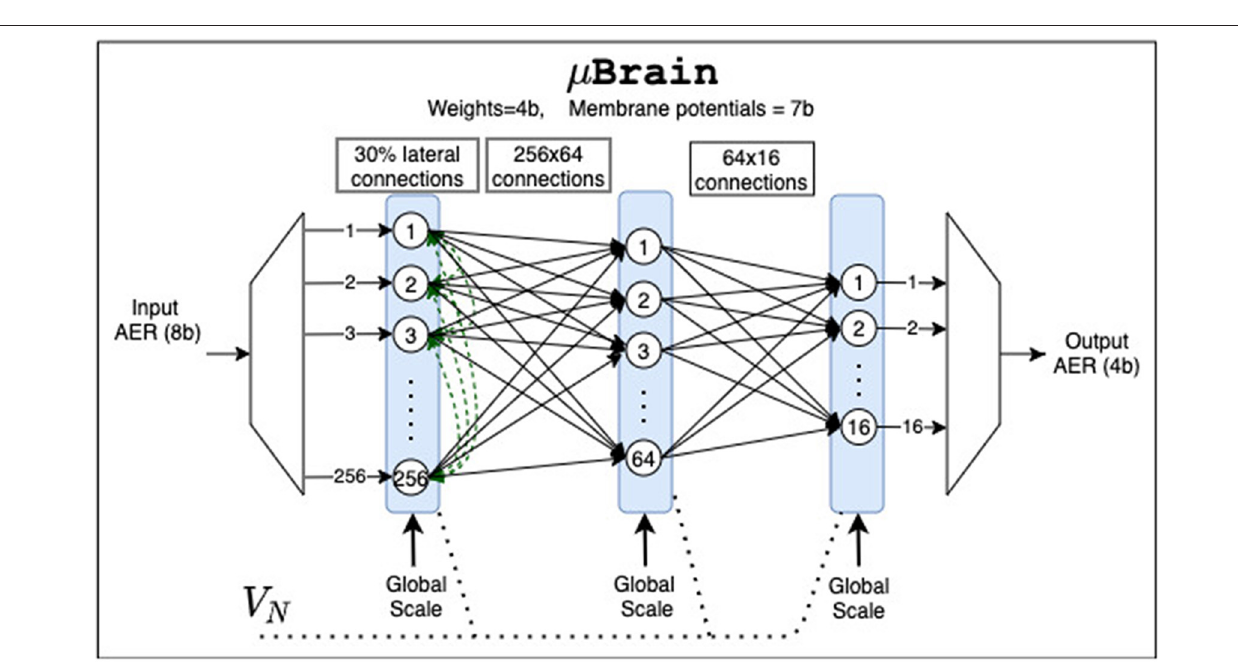
FIGURE 4 | µ Brain’s ASIC instantiation for the experiments in this paper consists of three layers: a recurrent layer of 256 neurons with circa 30% lateral connectivity and two fully connected layers counting 64 and 16 neurons, respectively. V N is the global near-threshold bias voltage used to tune the delay cells. The global scale inputs are digital inputs used to set to scale within a layer the synaptic